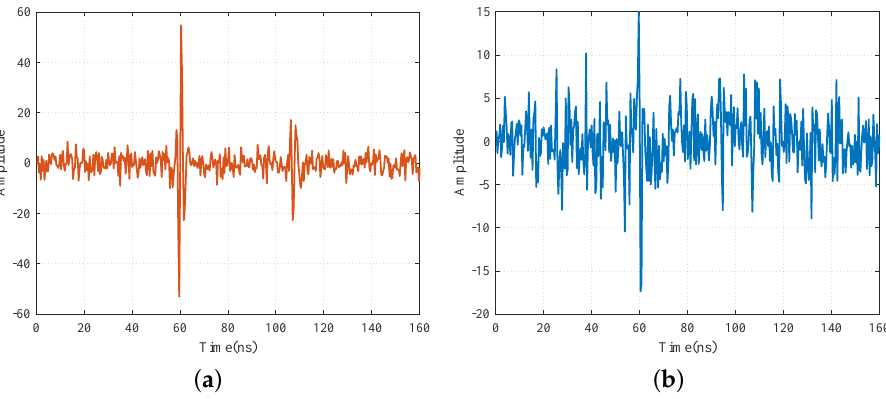
Figure 12. The 75th trace of profiles after adding noise. ( a ) HH polarization mode. ( b ) HV polariza- tion